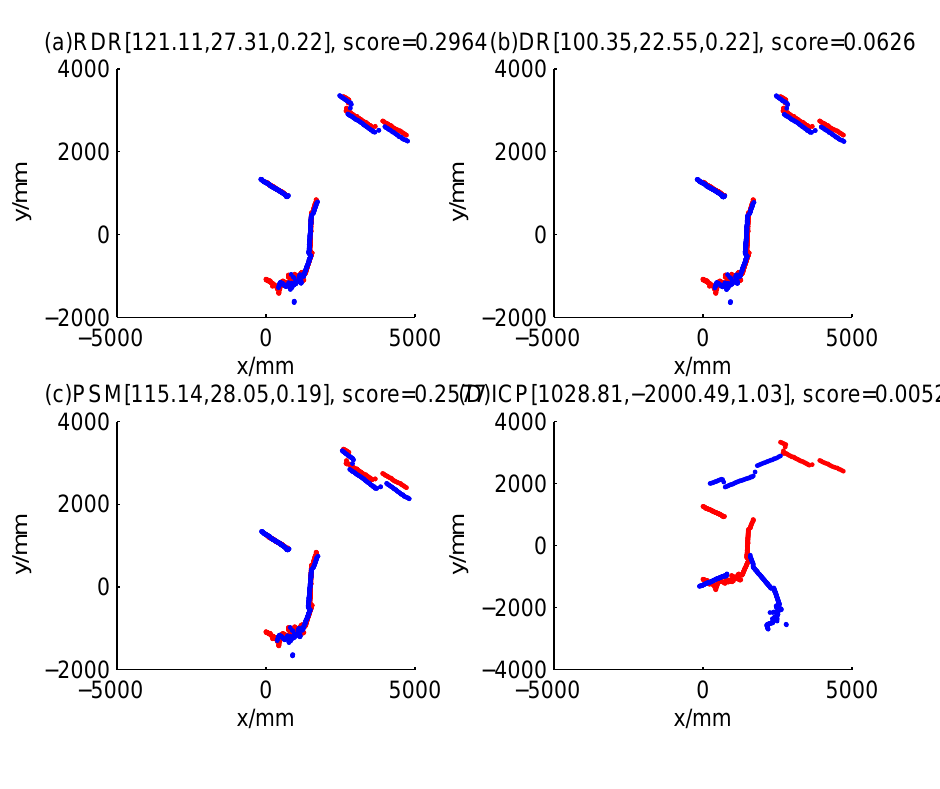
Figure 7. Raw scan match of the results of four methods (time Step 5).